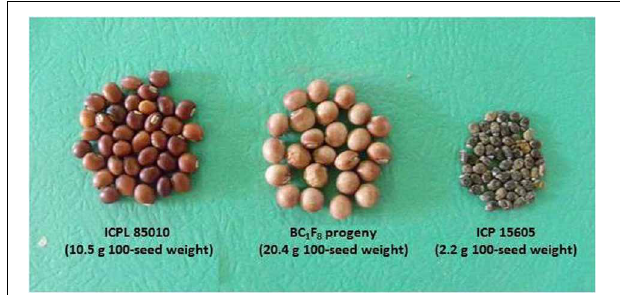
FIGURE 2 | Improvement of seed traits in cultivated pigeonpea by using Cajanus acutifolius